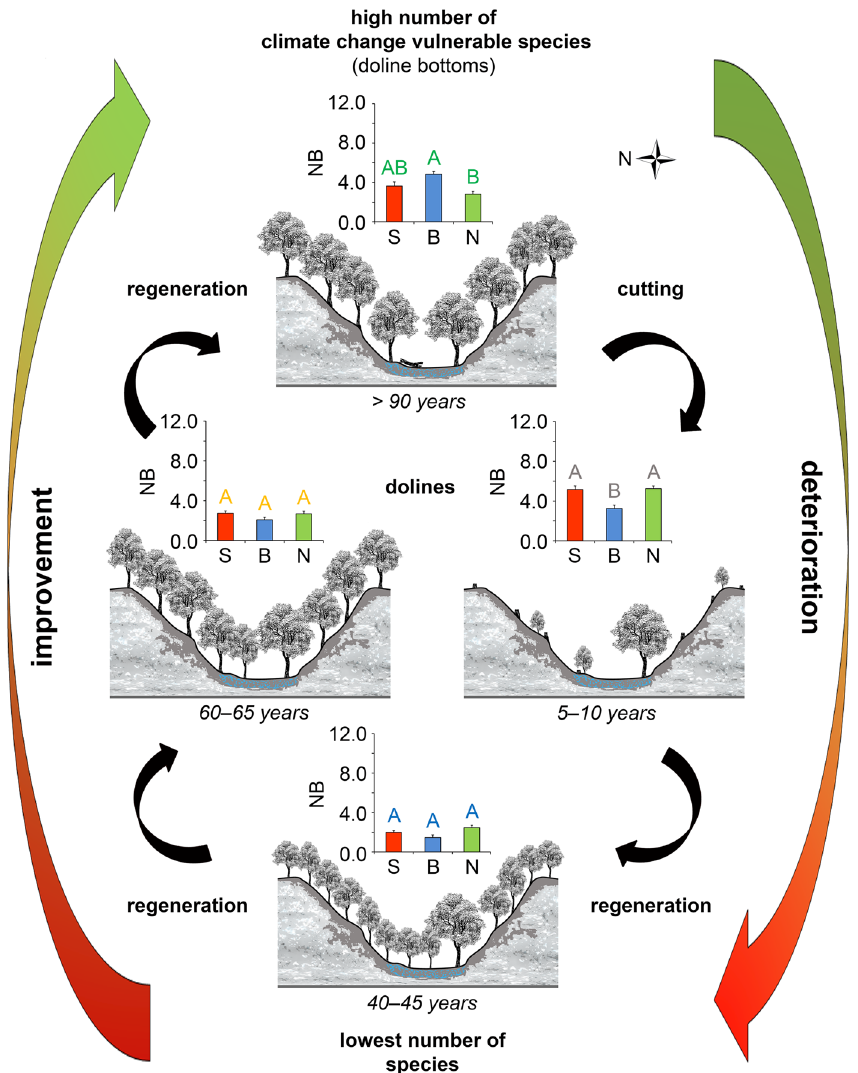
Fig. 7 Effects of forest management on the vegetation in dolines in the Mecsek Mts, Hungary. The total number of species and the number of climate change vulnerable plant species (i.e. beech forest species) may change due to intensive logging. Doline bottoms covered with more than 90-year-old forests may provide important microhabitats for many beech forest species (see bar charts and Fig. 6). The number of these species may decrease at doline bottoms and increase on the slopes after 5–10 years of logging. The competitive effect of the dense and shady thickets of young trees upon understory herbs and shrubs during the forest regeneration phase may be responsible for the significant decrease in species richness of dolines. Most plant species associated with the oldest forest stands may re-establish within 90–120 years after a regeneration felling. Abbreviation: NB , number of beech forest species in the